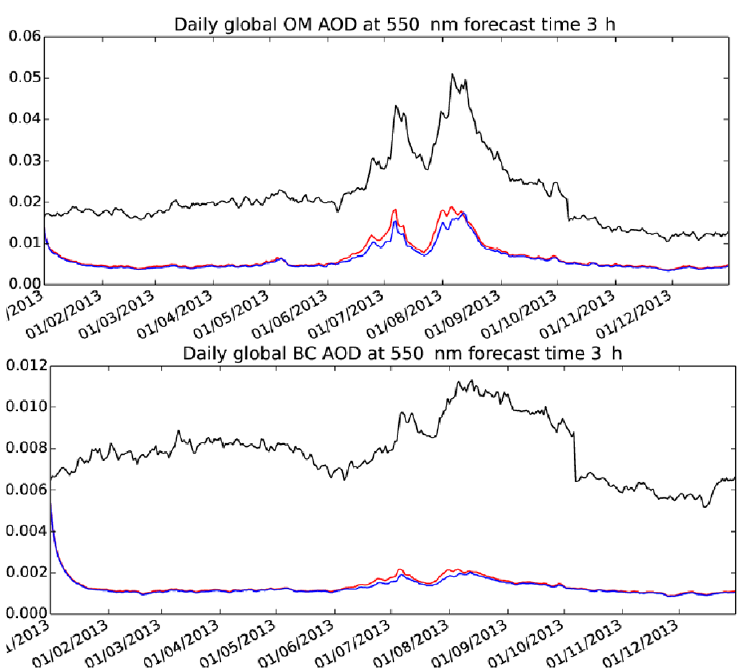
Figure 8. Global optical depth at 550nm of organic matter (OM) aerosol (top) and black carbon (BC, bottom) for the year 2013, simulated by C-IFS. The simulation with data assimilation is shown in black (biomass burning emissions are prescribed at the surface), without assimilation and with biomass burning aerosol emissions prescribed at the surface is in blue and at the PRM injection height in